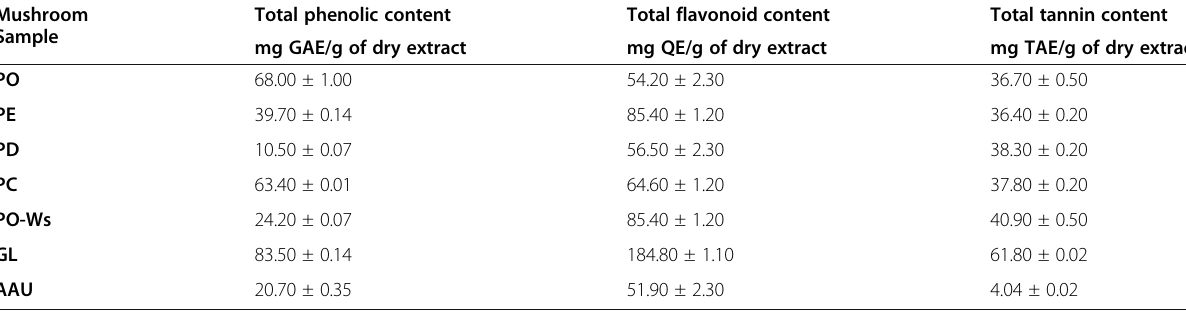
Table 4 Bioactive antioxidant components of the collected Bangladeshi edible mushrooms Mushroom